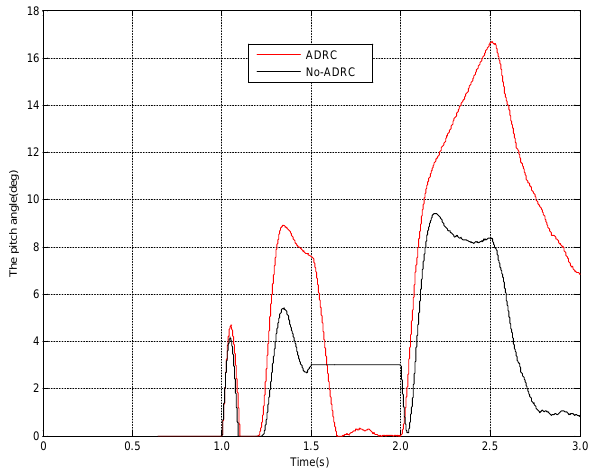
Figure 24. Simulation curve of pitch angle.